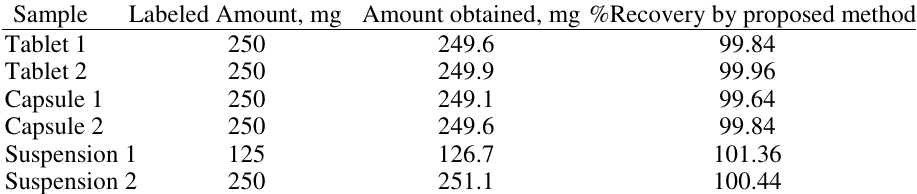
Table 2. Estimation of amoxicillin trihydrate in marketed formulations